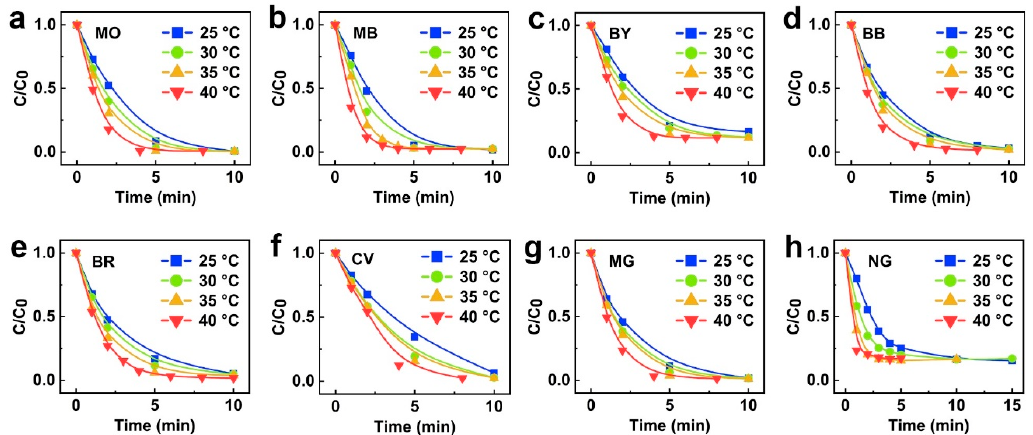
Figure 2. Decolorization of ( a ) MO, ( b ) MB, ( c ) BY, ( d ) BB, ( e ) BR, ( f ) CV, ( g ) MG and ( h ) NG by Fe 78 Si 9 B 13 metallic glass ribbons under 25–40 °C without UV-Vis irradiation (dye concentration: 20 ppm, catalyst dosage: 0.5 g/L, H 2 O 2 concentration: 1 mM, pH 3.0). Decolorization rates were measured from the λ max of corresponding UV-Vis spectra with reaction time.